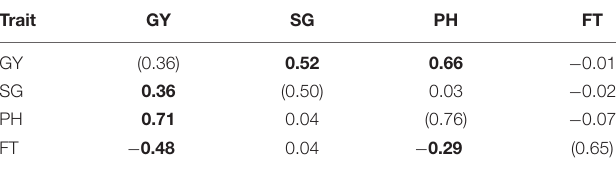
TABLE 1 | Heritabilities (diagonal; in parentheses), additive genetic (above diagonal), and residual (below diagonal) correlations a for grain yield (GY), stay-green (SG), plant height (PH), and flowering time